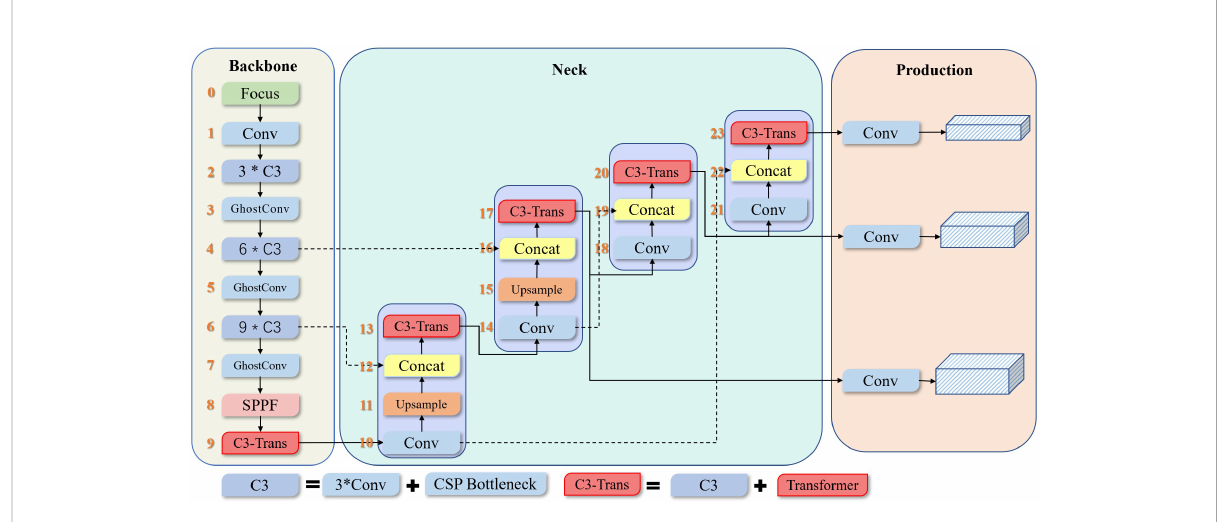
FIGURE 2 Improved YOLOv5 network structure proposed in this